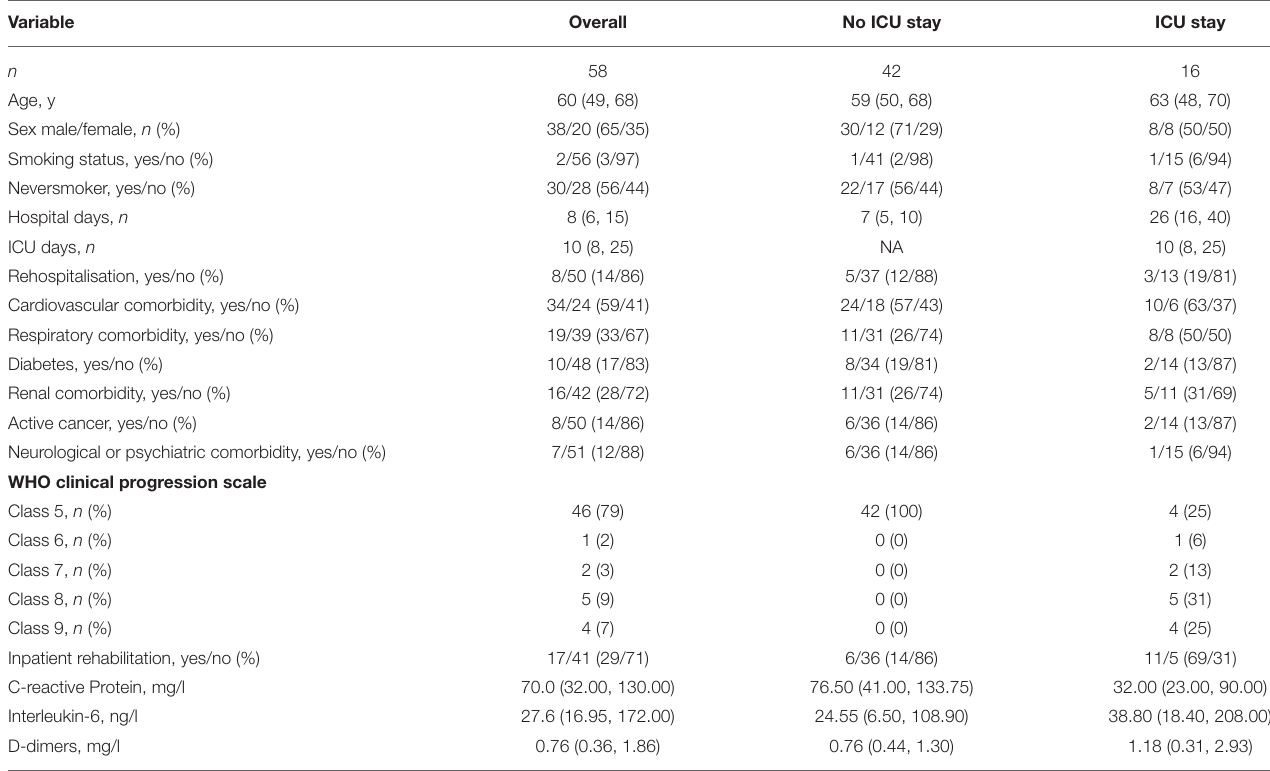
TABLE 1 | Participant characteristics for the overall sample and stratified according to ICU-status. Variable